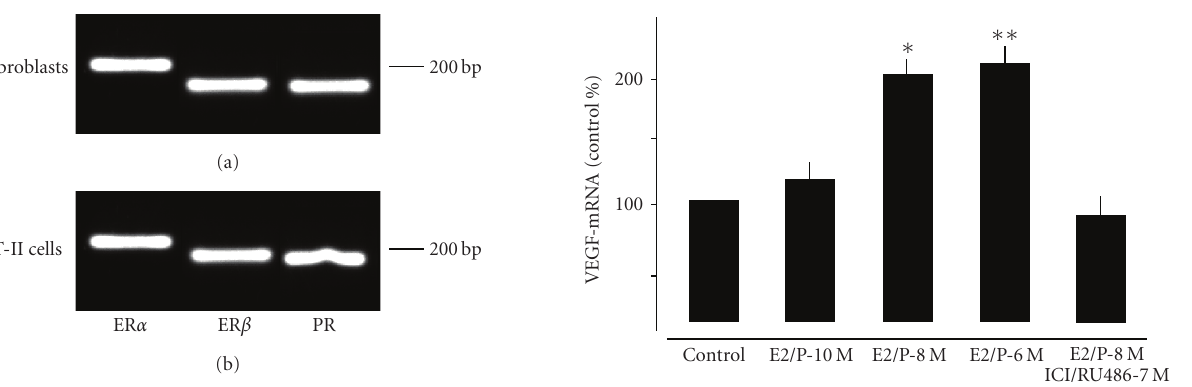
Figure 2: Semiquantitative analysis of estrogen receptor alpha (ER- α ), estrogen receptor beta (ER- β ), and the progesterone receptor (PR) expression in central lung fibroblast and AT-II cell cultures. Note that all three hormone receptors are expressed in both cell cultures.